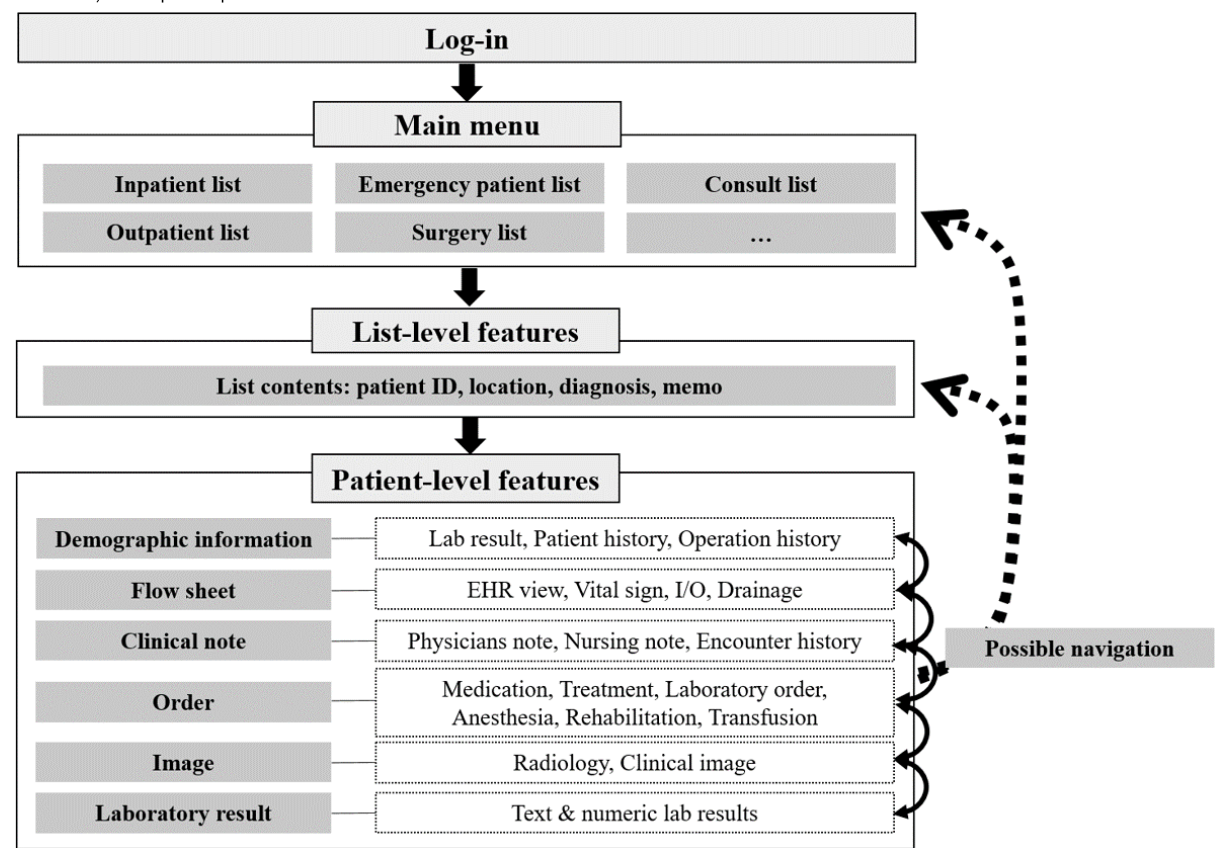
Figure 3. Feature list of mDARWIN. The system consists of 3 levels: main menu, list-, and patient-level features. EHR: electronic health record; ID: identification; I/O: